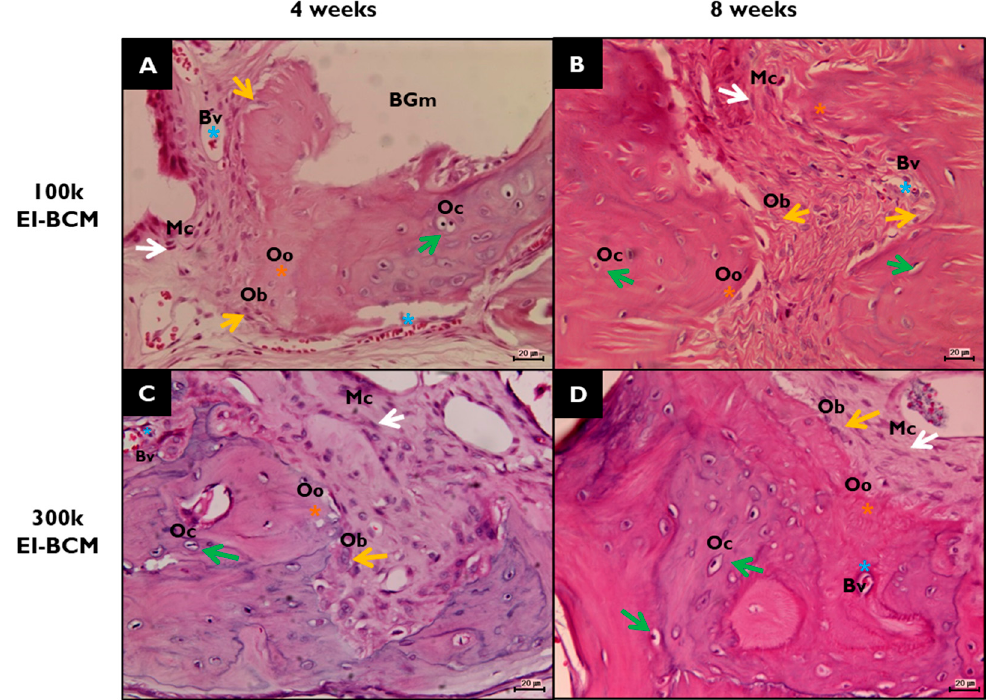
Figure 10. Histological view of new bone areas ( NBAs ) in H&E stained defect sites. ( A ) 100k EI-BCM group at 4 weeks after surgery; ( B ) 100k EI-BCM group at 8 weeks; ( C ) 300k EI-BCM group at 4 weeks; ( D ) 300k EI-BCM group at 8 weeks; NB , new bone; BGm , remaining graft materials; white arrow, mesenchymal cell ( Mc ); blue asterisk, blood vessel ( Bv ); yellow asterisk, osteoid ( Oo ); yellow arrow, osteoblast ( Ob ); green arrow, osteocyte ( Oc ) within lacuna (Original magnifications: 100×).